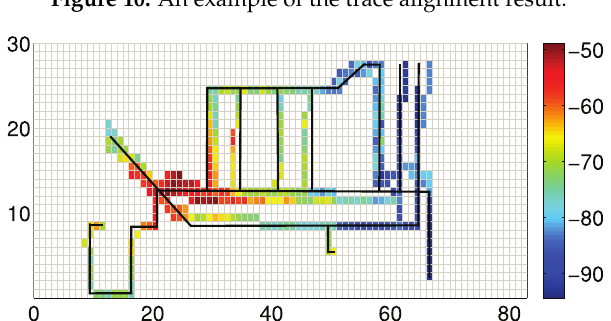
Figure 11. Map reconstruction with the aligned data traces.